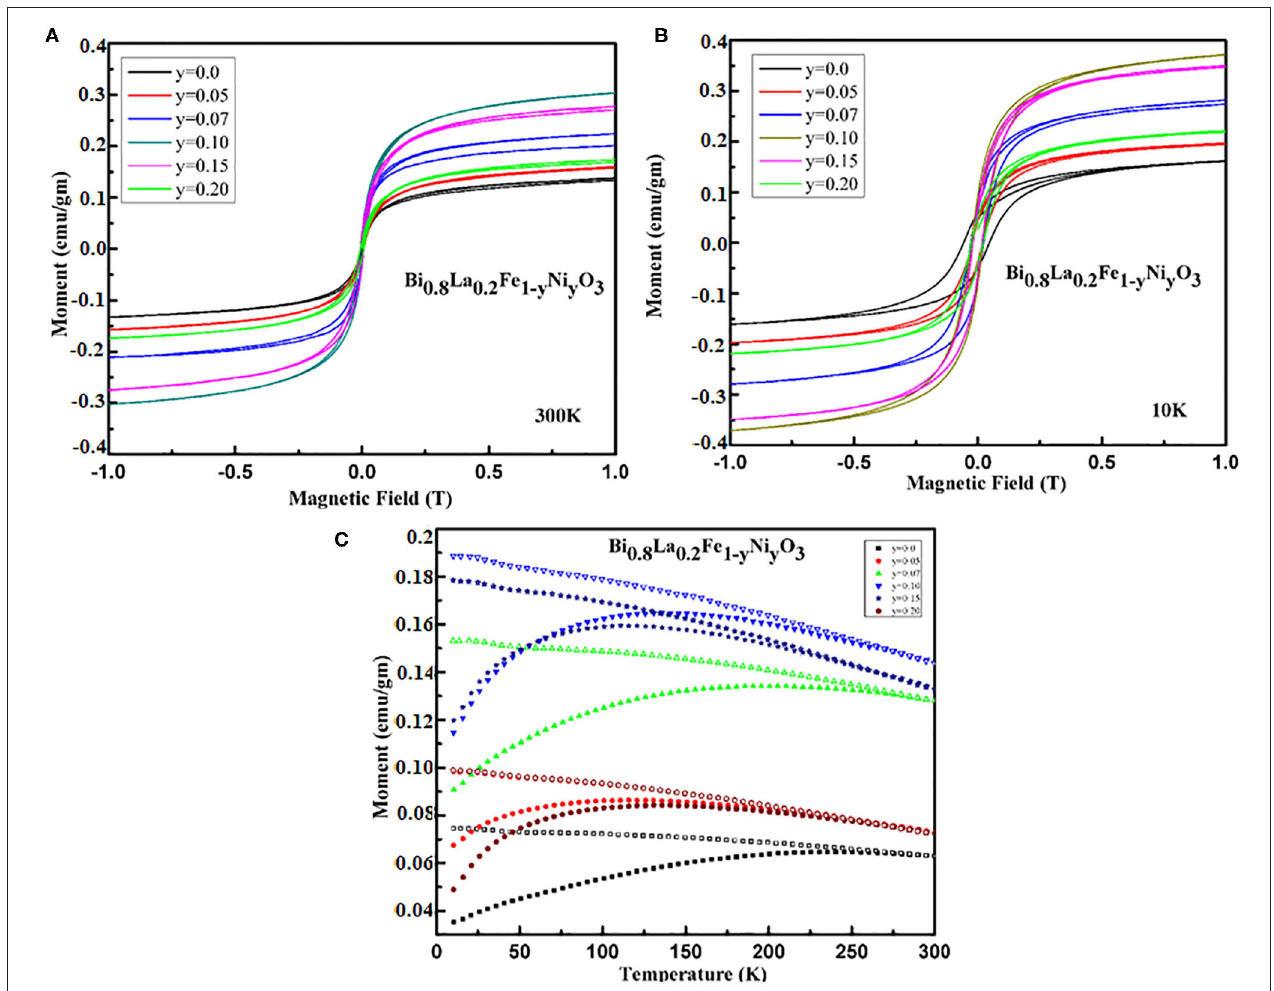
FIGURE 5 | Field dependences of the magnetization obtained for Bi 1 temperature and (B) x 0.0, 0.05, 0.07, 0.1, 0.15, 0.20) samples at constant field 500 =